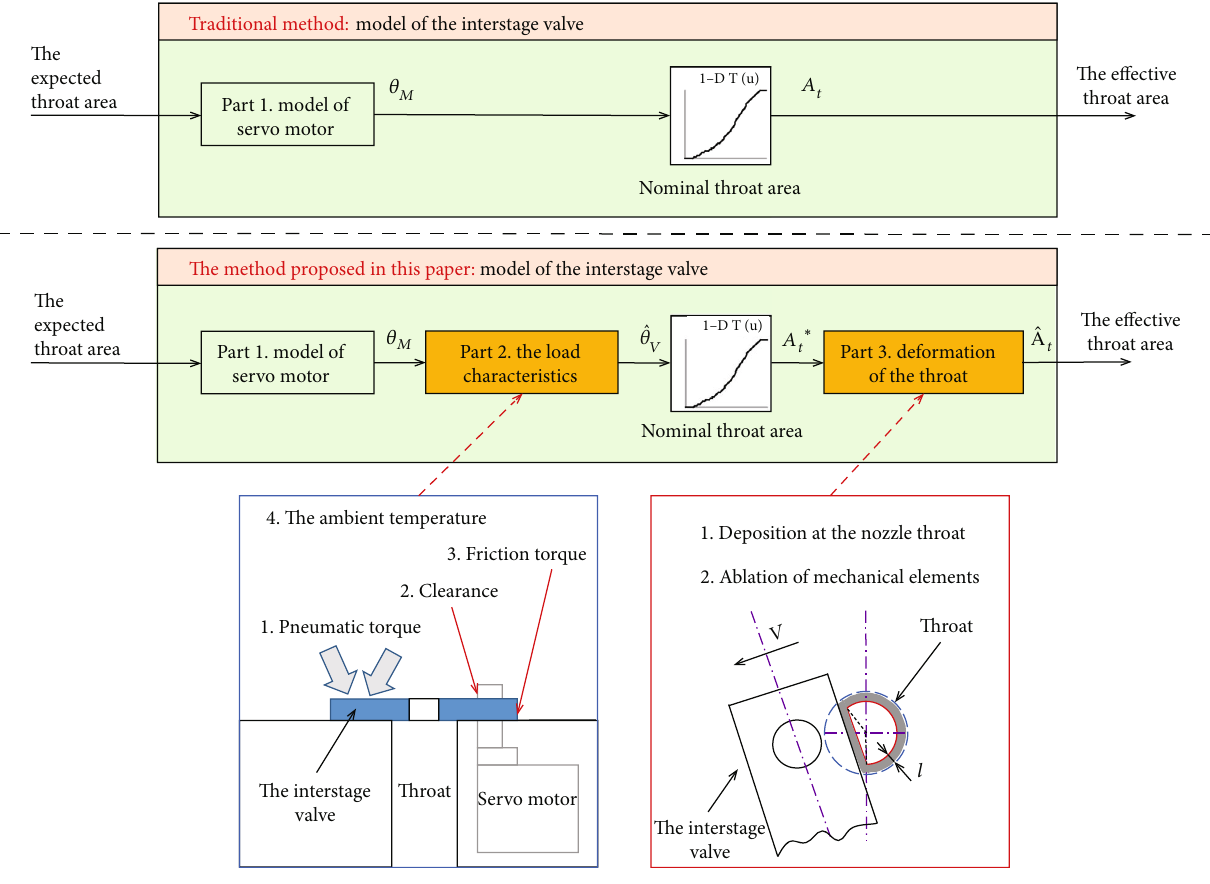
Figure 1: The composition and in fl uencing factors of the valve mathematical